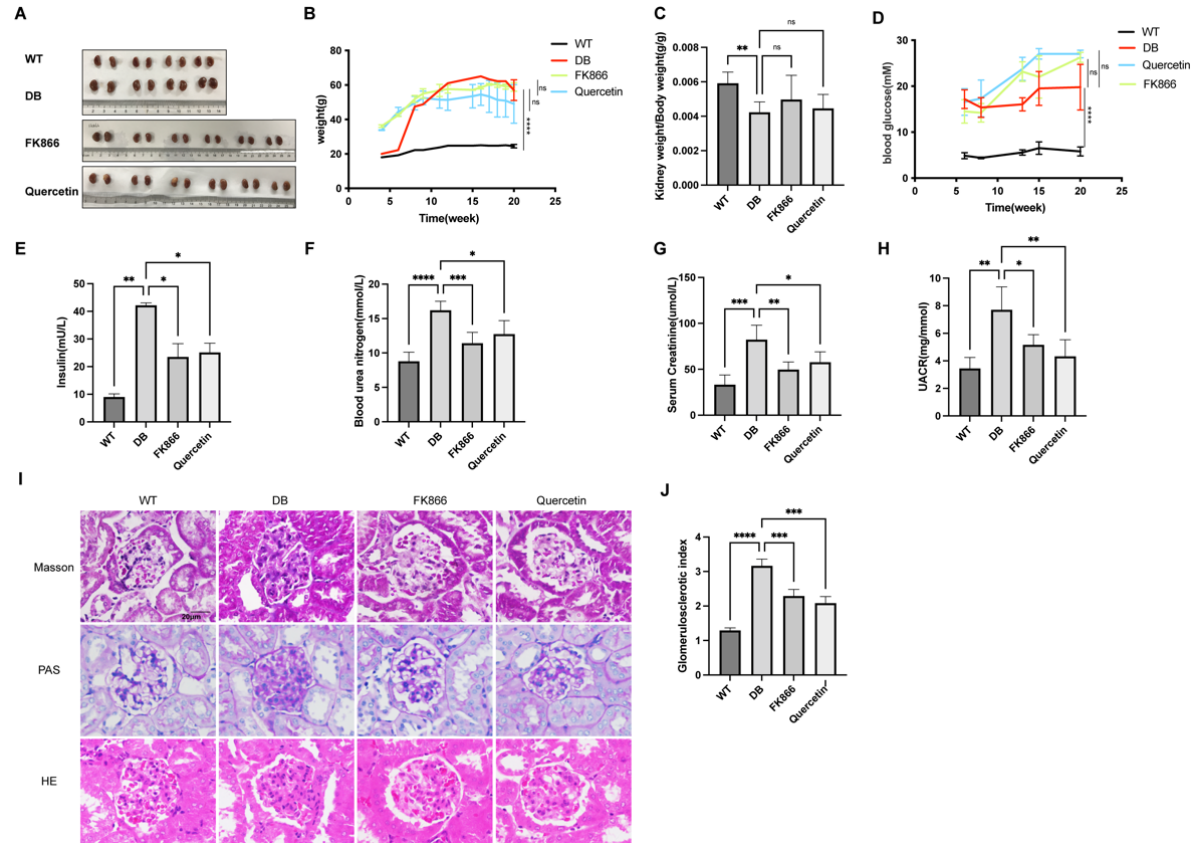
Figure 4. FK866 and quercetin effects on kidney function and renal pathology of morphology in db/db mice: ( A ) Renal images in different groups; WT or db/db group mice n = 4; FK866 or quercetin group n = 6. Measurement and analysis of the weight ( B ), kidney weight to body weight ratio ( C ), blood glucose ( D ), serum insulin ( E ) on mice. Renal function was evaluated by the levels of blood urea nitrogen ( F ), serum creatinine ( G ), and urine albumin to urine creatinine ratio ( H ). Light microscopy was used to observe renal morphologies. Representative photographs are shown for hematoxylin– eosin (HE), Masson and Periodic Acid–Schiff (PAS) staining with 20 × 10 magnification ( I ). The glomerulosclerotic index ( J ) were calculated from 5 to 10 randomly images of each mouse depending on PAS staining. Data are represented as the mean ± SD; n = 3; scale bar = 20 µ m; ns means no significance, * p ≤ 0.01, ** p < 0.01, *** p < 0.001, **** p < 0.0001.